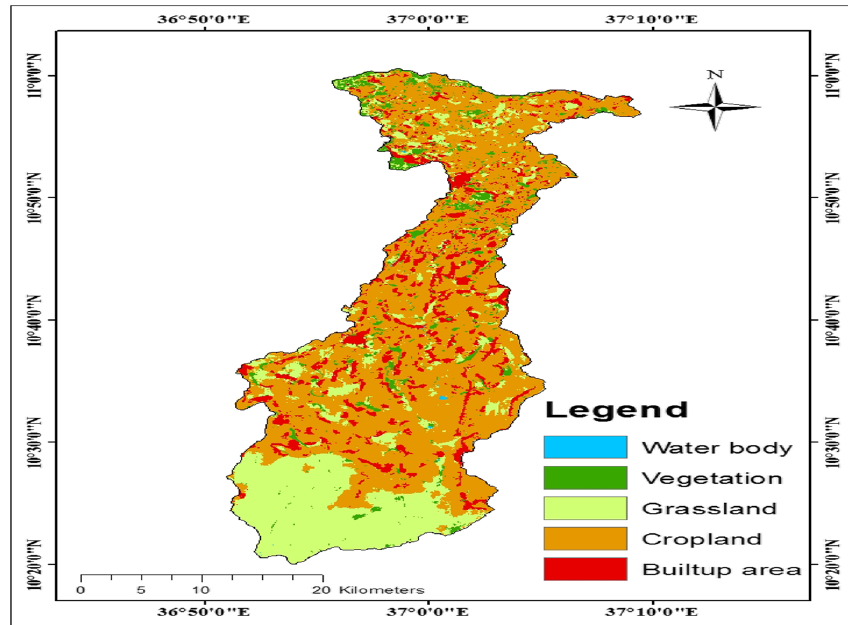
Fig. 9 A map of land use and